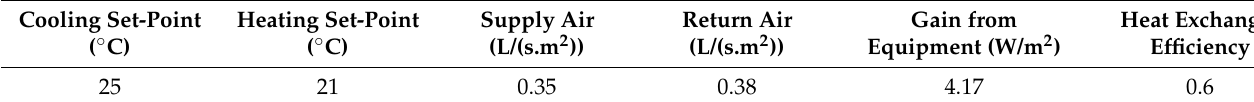
Table 3. Mechanical ventilation specifications implemented in the study.